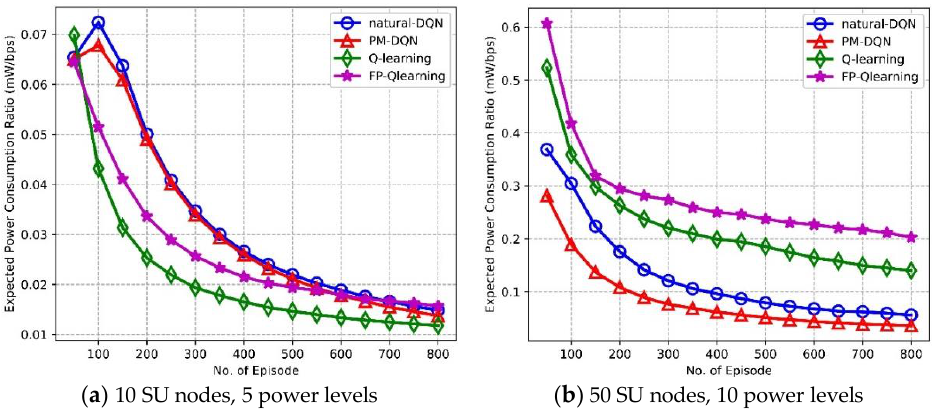
Figure 10. Expected power consumption ratio vs. the number of episodes.